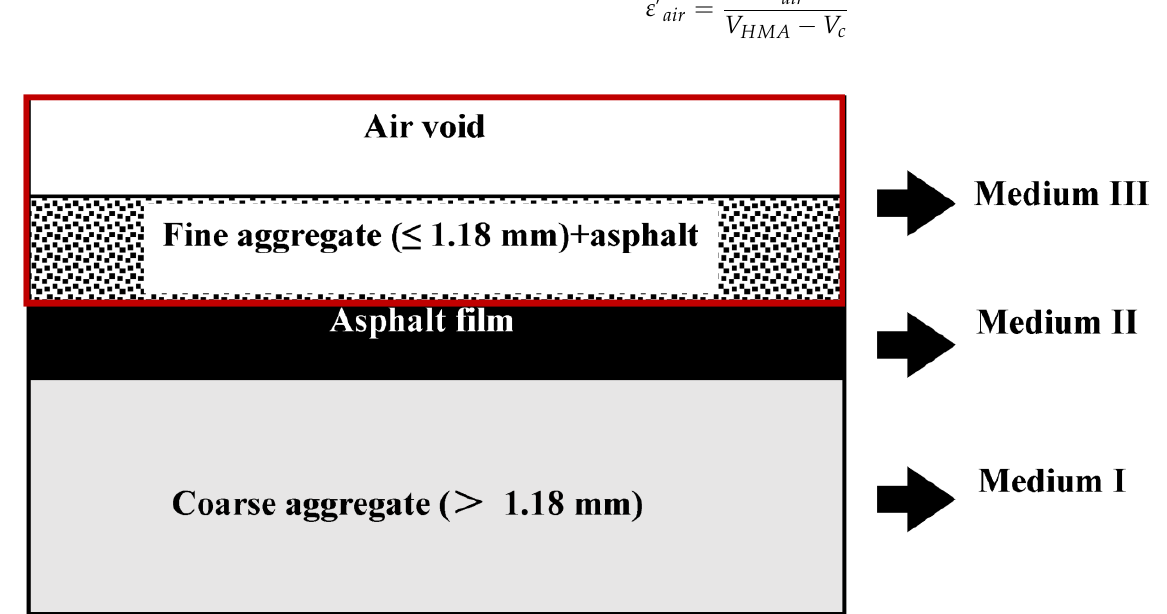
Figure 10. Volume relationship of the asphalt mixture.